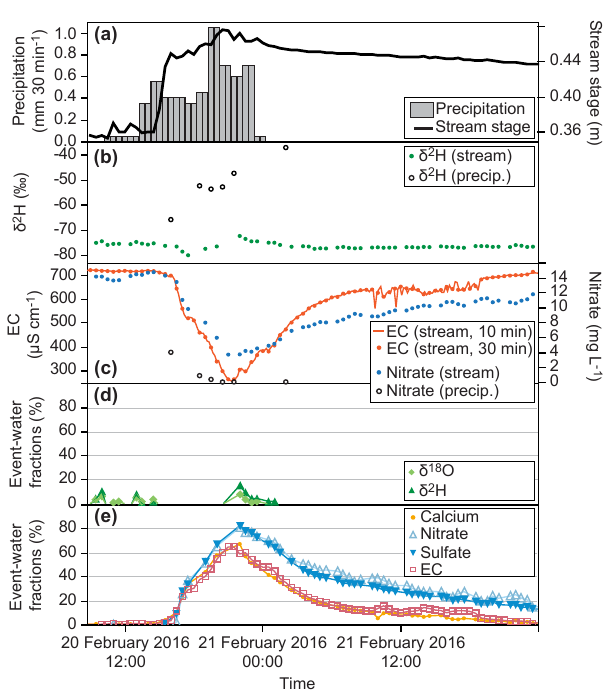
Figure 8. Precipitation Event 2 and the (a) hydrologic, (b) isotopic, and (c) chemical responses in stream water. Panels (d) and (e) show the fractions of event water ( F E ) based on isotopic and chemical hy- drograph separation. Chemical tracers greatly exaggerate the event- water